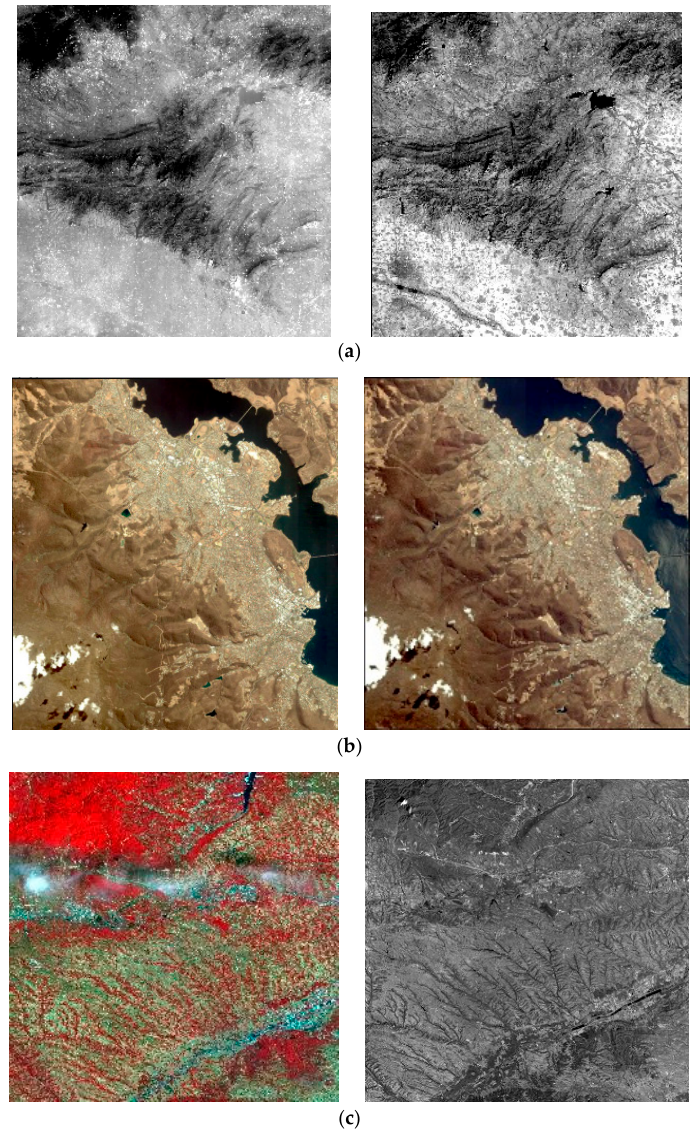
Figure 7. Three datasets are used for experiments which are downloaded from the homepage of ISPRS (http://www.isprs.org/data). ( a ) The dataset 1 consists of a pair of ZY3 multispectral images (5.8 m/pixel, 8817 pixel × 9215 pixel). The reference image is the green band (0.52–0.60 μ m), the sensing image is near-infrared band (0.76–0.90 μ m); ( b ) Dataset 2 consists of a pair of IKONOS panchromatic images (1 m/pixel, 12,122 pixel × 13,148 pixel); ( c ) Dataset 3 acquired by ZY3 consists of a multispectral (MS) image (5.8 m/pixel, 8817 pixels × 9283 pixels) and a panchromatic (PAN) image (2.1 m/pixel, 24,525 pixels × 24,410 pixels).